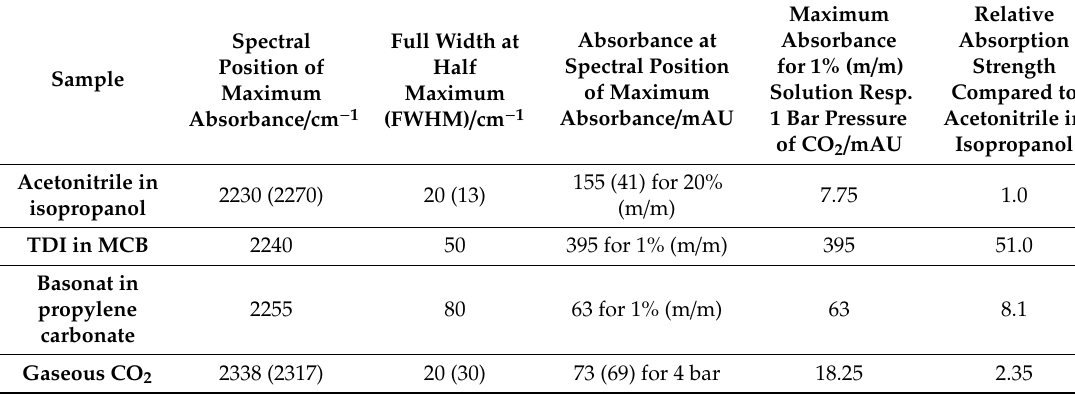
Table 2. Peak absorbances of sample spectra from Figure 3b. Values for the second maxima are in brackets. The relative absorption strength is calculated for the main peaks.